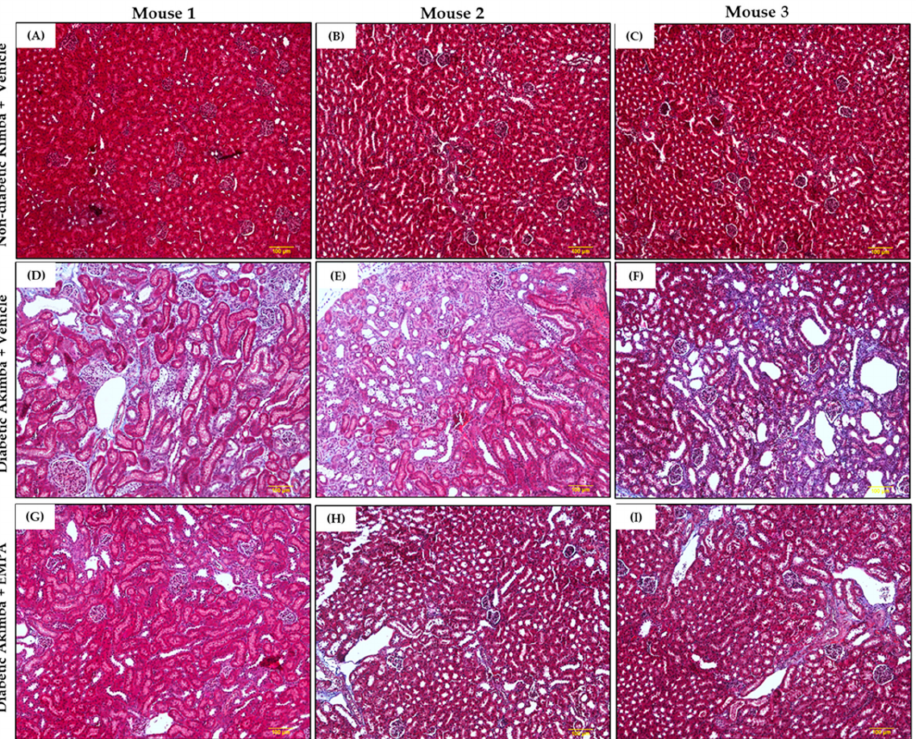
Figure 10. Representative images of Masson’s Trichrome-stained kidney tissues from non-diabetic Kimba mice treated with Vehicle ( A – C ), diabetic Akimba mice treated with Vehicle ( D – F ) and diabetic Akimba mice treated with EMPA ( G – I ). Collagen fibers stained blue in diabetic kidneys indicating renal interstitial fibrosis. Scale bar = 100 µ m; Magnification = 100 × ; representative images are shown for 3 mice/group. EMPA: Empagliflozin.